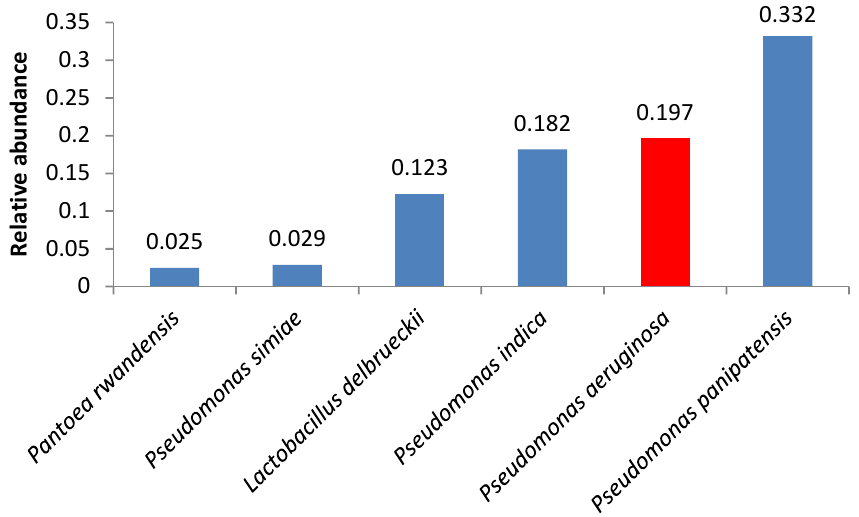
Figure 1. Relative abundance of amplicon sequence variants in butter sample no. 4.